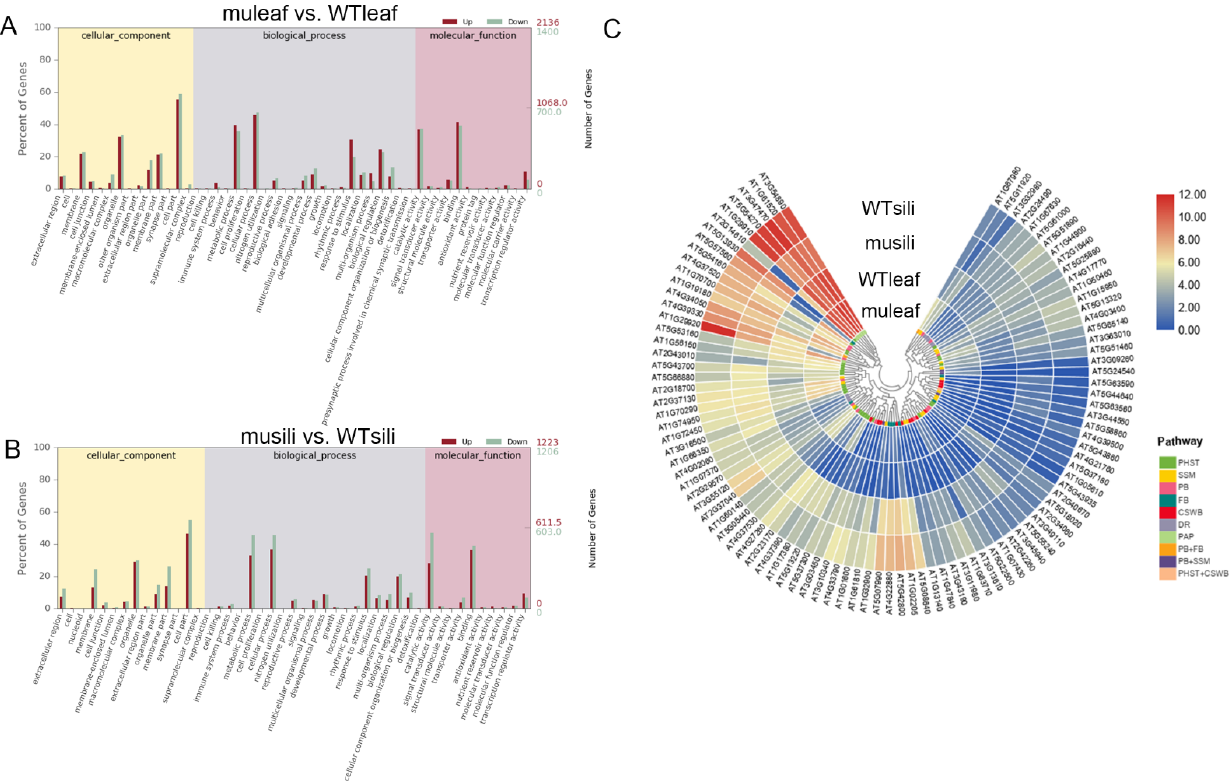
Figure 9. GO enrichment analysis and KEGG pathway analysis. ( A , B ) Gene Ontology (GO) analysis of cellular components, biological processes and molecular functions of muleaf vs. WT ( A ) and musili vs. WT ( B ). ( C ) KEGG pathway and cluster analysis of 99 DEGs. Plant hormone signal transduction (PHST); starch and sucrose metabolism (SSM); phenylpropanoid biosynthesis (PB); flavonoid biosynthesis (FB); cutin, suberin and wax biosynthesis (CSWB); DNA replication (DR); and photosynthesis (PAP). Table 2. KEGG pathway analysis of pip1s - mutant RNA-sequencing data. Pathway Up Count Down Count q -Value muleaf vs.